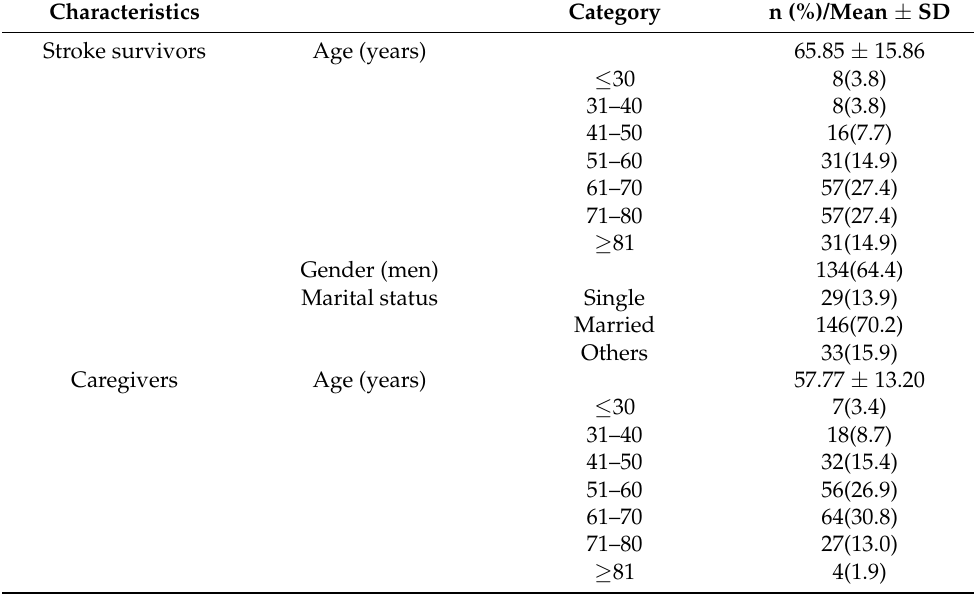
Table 1. General characteristics of participants (N =